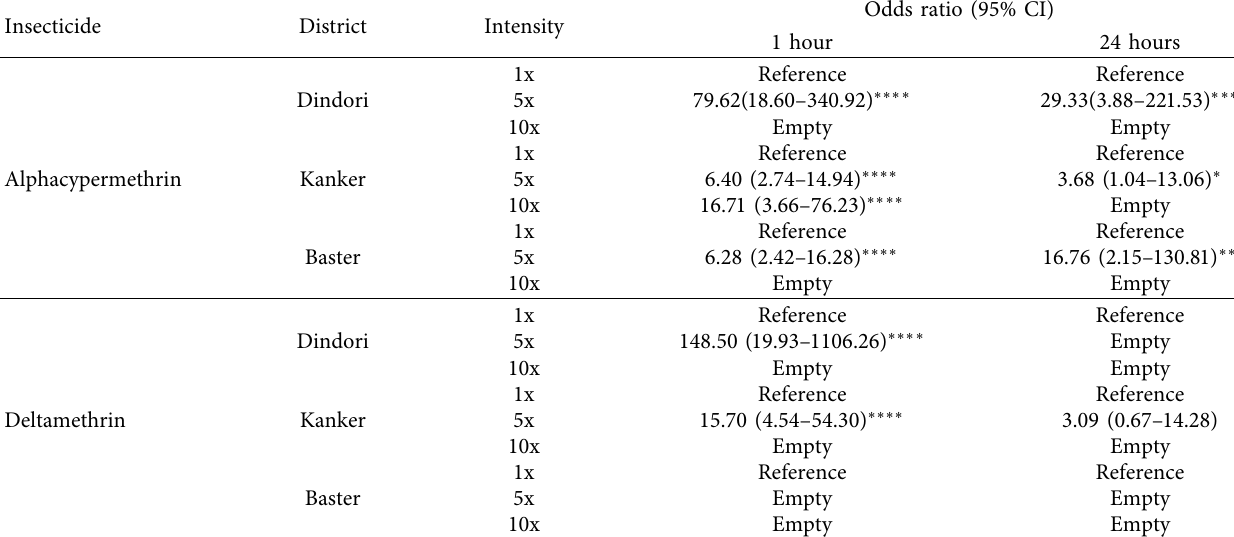
Table 2: Logistic regression of mortality of An . culicifacies associated with the intensity of bioassay of alphacypermethrin and deltamethrin in districts Dindori (Madhya Pradesh), and Kanker and Baster (Chhattisgarh).